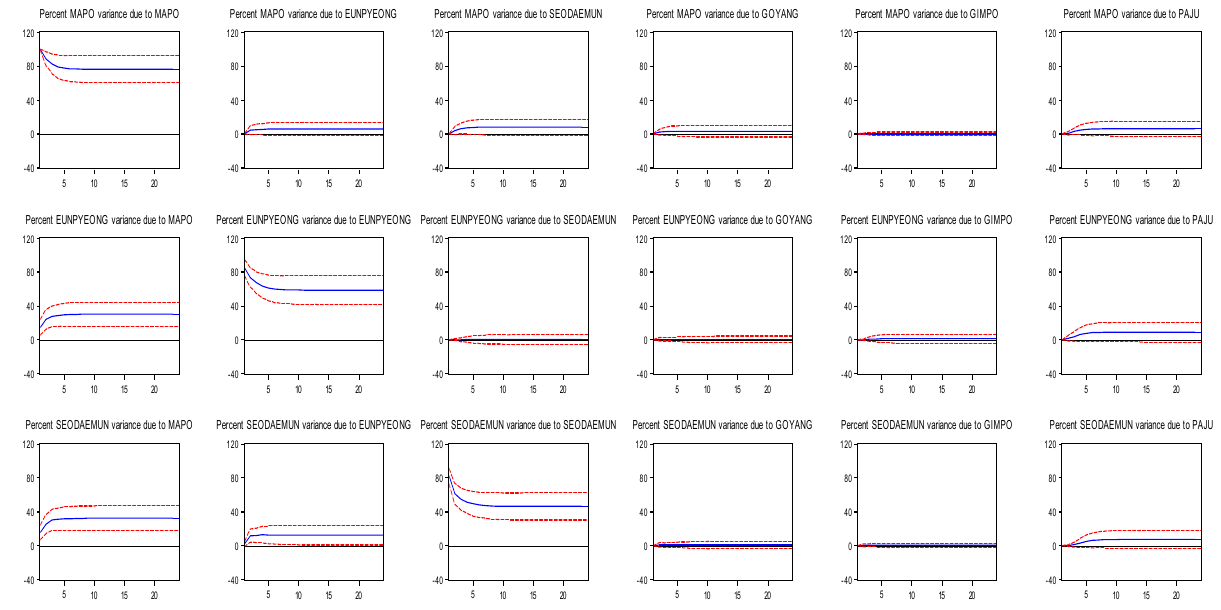
Figure 5. Variance decomposition analysis of the jeonse market in the Northwest region.